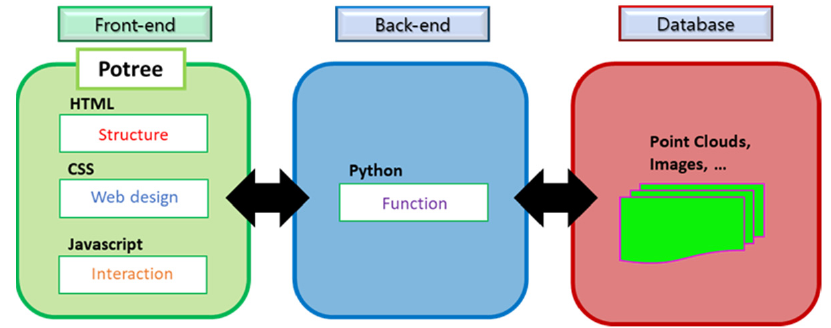
Figure 17. Architecture of the Potree web-visualization portal established in this study.